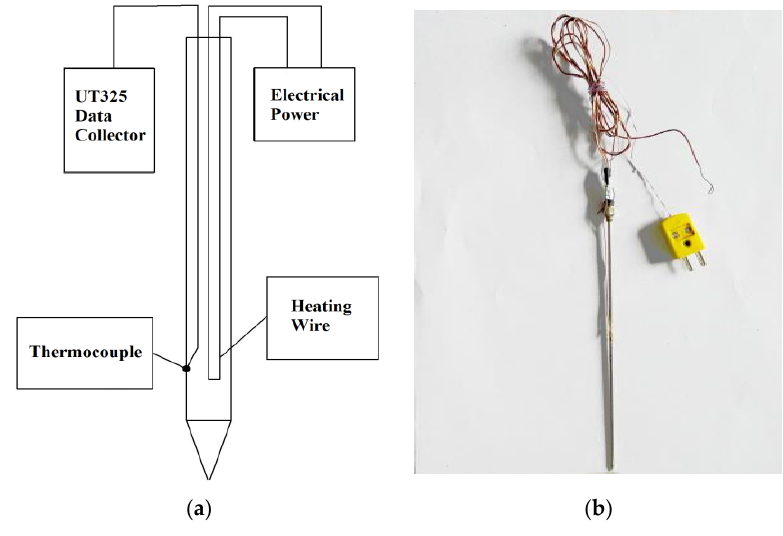
Figure 3. The needle probe used in the test, ( a ) illustration; ( b ) product. Table 1. The technical parameters of the needle probes used.